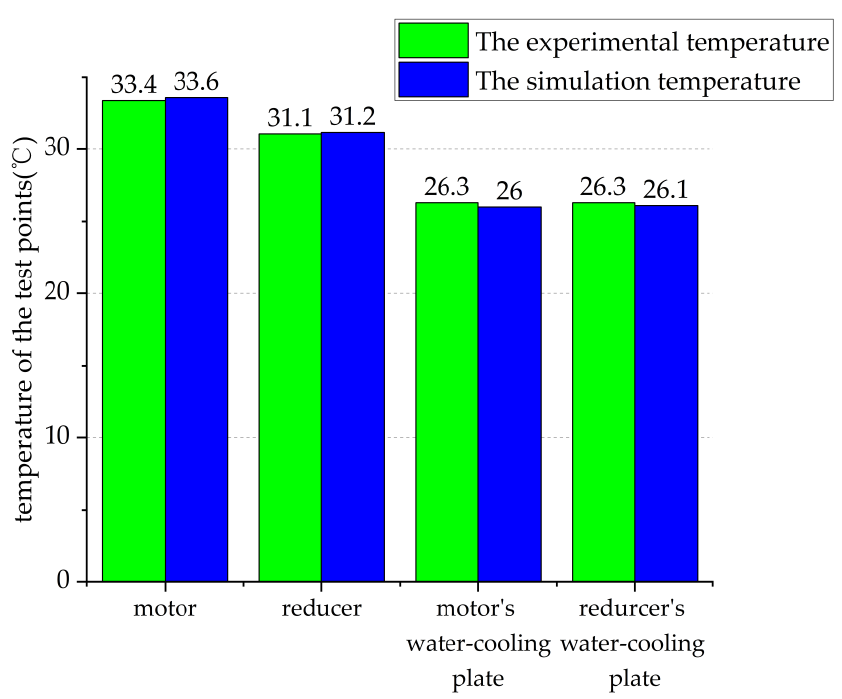
Figure 13. Comparison of simulated temperature in working condition 2 test.